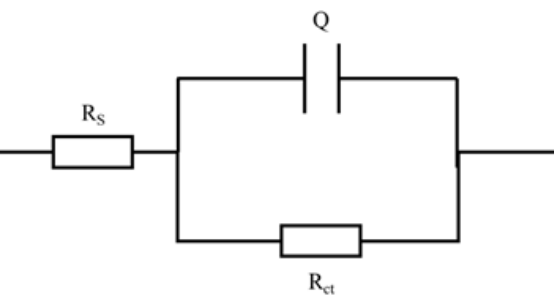
Figure 9. Equivalent circuit of electrochemical impedance spectroscopy (EIS) of S32750 stainless steel at different annealing temperature. Table 4. Equivalent circuit parameter values for S32750 stainless steel samples at different annealing temperatures. R s is the resistance of the solution, R ct is the resistance of charge transfer, Q is the constant phase element (CPE), n is the CPE exponent (0 ≤ n ≤ 1).